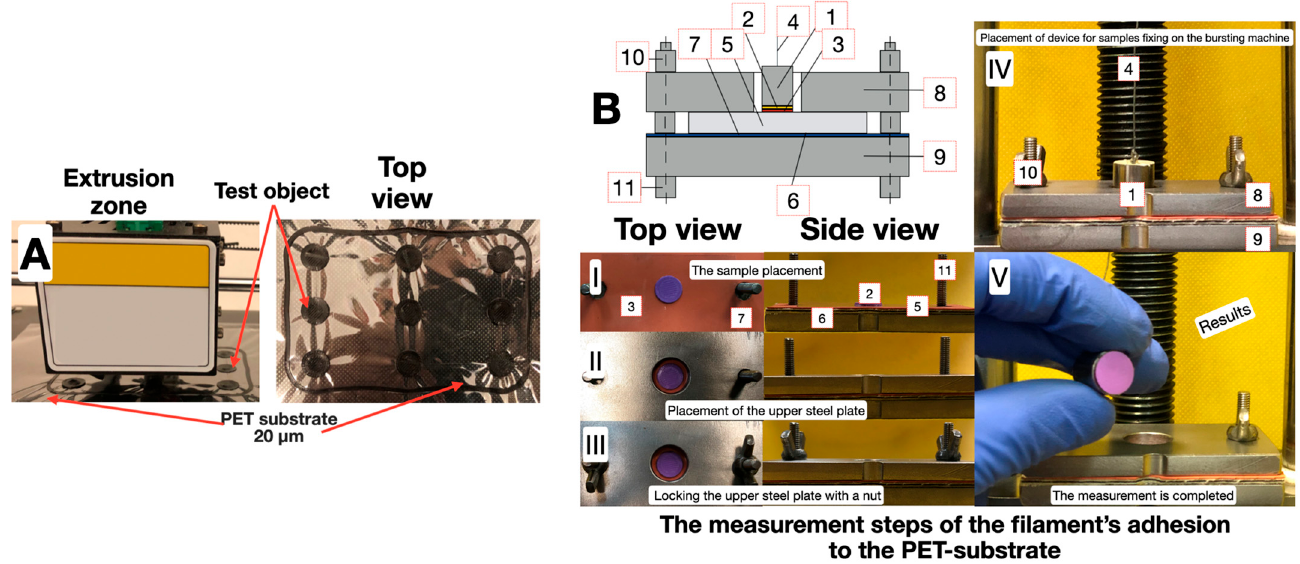
Figure 2. The 3D-printed test objects on the surface of the PET-substrate ( A ); the diagram of the device for sample fixing on the Instron 3382 bursting machine: 1—the metal cylinder with an adhesive layer; 2—the test object; 3—the PET-substrate; 4—the Kevlar twisted thread; 5—the tested sample; 6—the double-sided adhesive tape; 7—the rubber gasket; 8 –the upper steel plate with a hole for the metal cylinder; 9—the lower steel plate; 10—the nut; 11—the bolt ( B ) [72]. Next, a metal cylinder with an area of 1 cm 2 was fixed on the test object using the cyanoacrylate glue “Moment” (“Henkel”) and was attached to the upper clamp of the Instron 3382 bursting machine by means of a flexible rod. The strength values were registered in the StretchTest